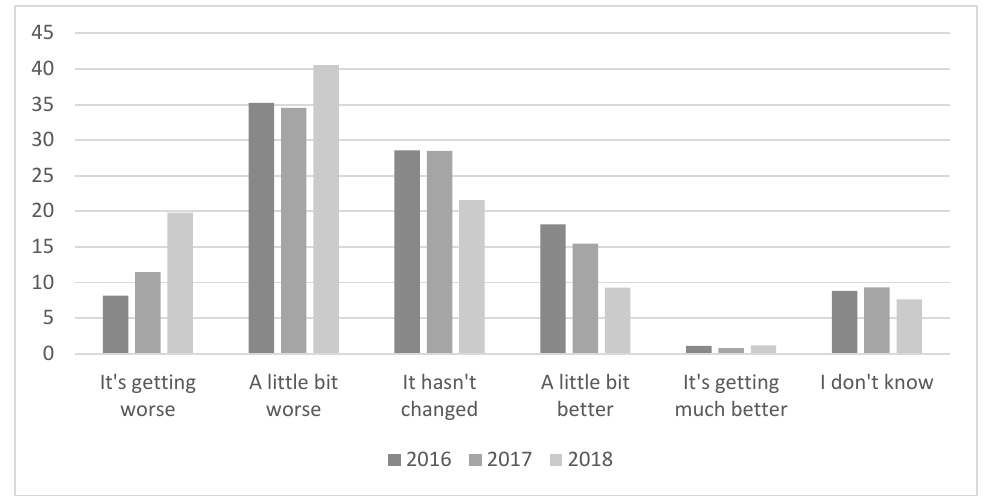
Figure 2. When you think about the state of our forests in general, do you feel that the state is improving, not changing or getting worse? (data in %, source A2016, A2017, A2018).